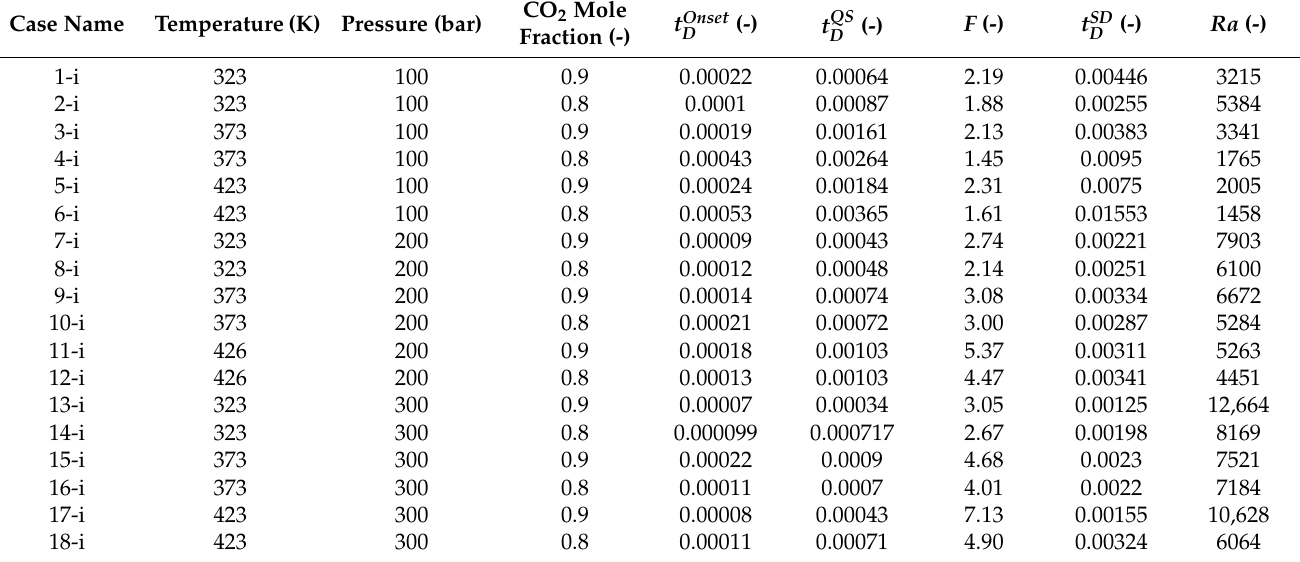
Table 4. Details of the impure CO 2